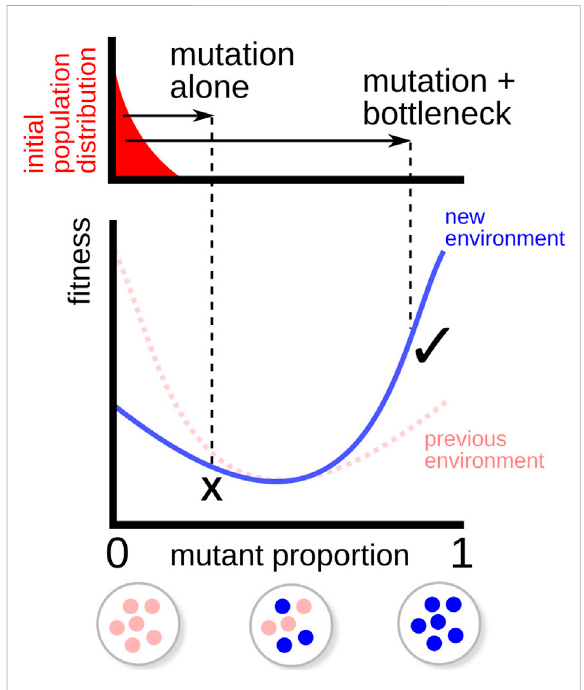
FIGURE 5 Illustration of fi tness valley traversal. A population (top, red) is initially adapted to a particular environment ( fi tness function in dashed line), favouring a particular complement of organelle genomes (bottom). When the environment changes ( fi tness function in solid line), the optimal complement changes too, but the fi tness penalty associated with mixed organelle populations prevents “ hill-climbing ” adaptation to the new optimum through mutationalone(×).Whencombinedwithageneticbottleneck,the moderate heteroplasmy arising from mutation allows some offspring to cross this fi tness valley and adapt more readily to the new environment ( ✓